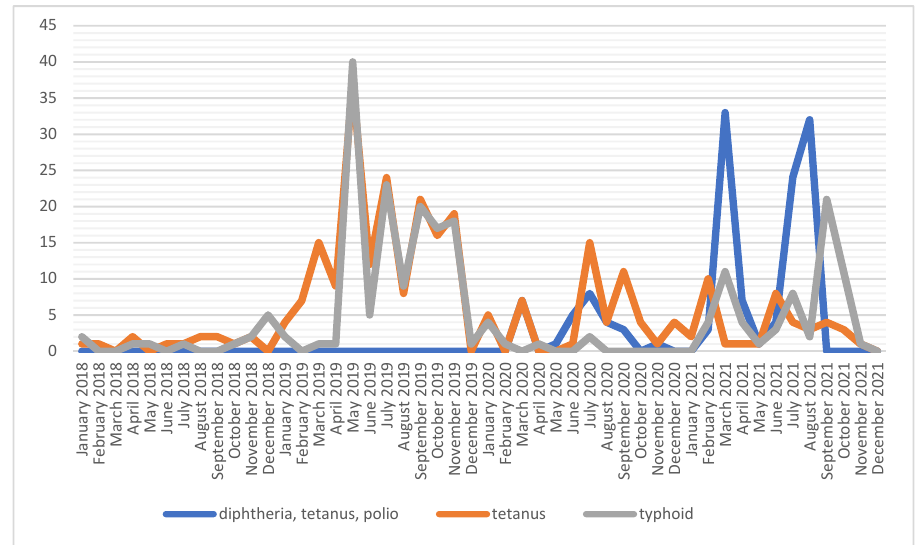
Figure 2. Number of vaccinations against diphtheria, tetanus, polio and typhoid fever among soldiers in 2018–2021.